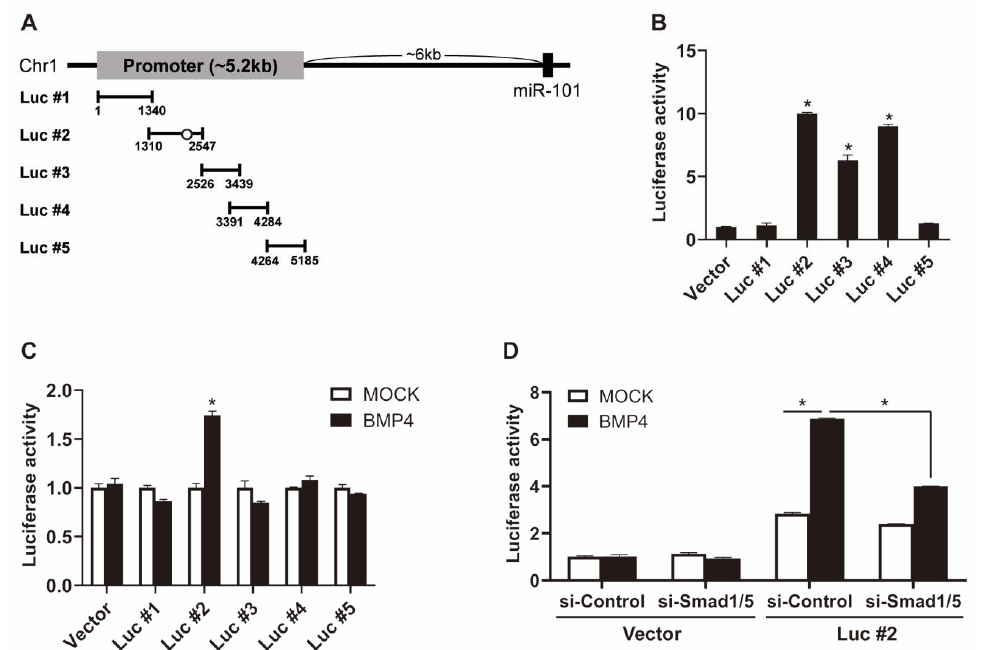
Figure 4. Smad1/5 mediates transcriptional regulation of miR-101. ( A ) Schematic diagram of luciferase reporter constructs containing putative promoter region of the miR-101 gene. A conserved Smad-binding element (5’-CAGAC-3’) is shown as an open circle. ( B ) Luciferase activities of constructs, such as Luc #1~5, were examined in Cos7 cells. An empty vector was used as a control (Vector). The data represent the mean ± S.E. of triplicates. *, p < 0.05. ( C ) The relative luciferase activity of each construct with BMP4 stimulation relative to unstimulated is shown. The data represent the mean ± S.E. of triplicates. *, p < 0.05. ( D ) Cos7 cells were cotransfected with an empty vector or Luc #2 construct and si-Control or si-Smad1/5 for 24 h, followed by BMP4 treatment for 24 h. Luciferase activities were then measured. The data represent the mean ± S.E. of triplicates. *, p < 0.05.